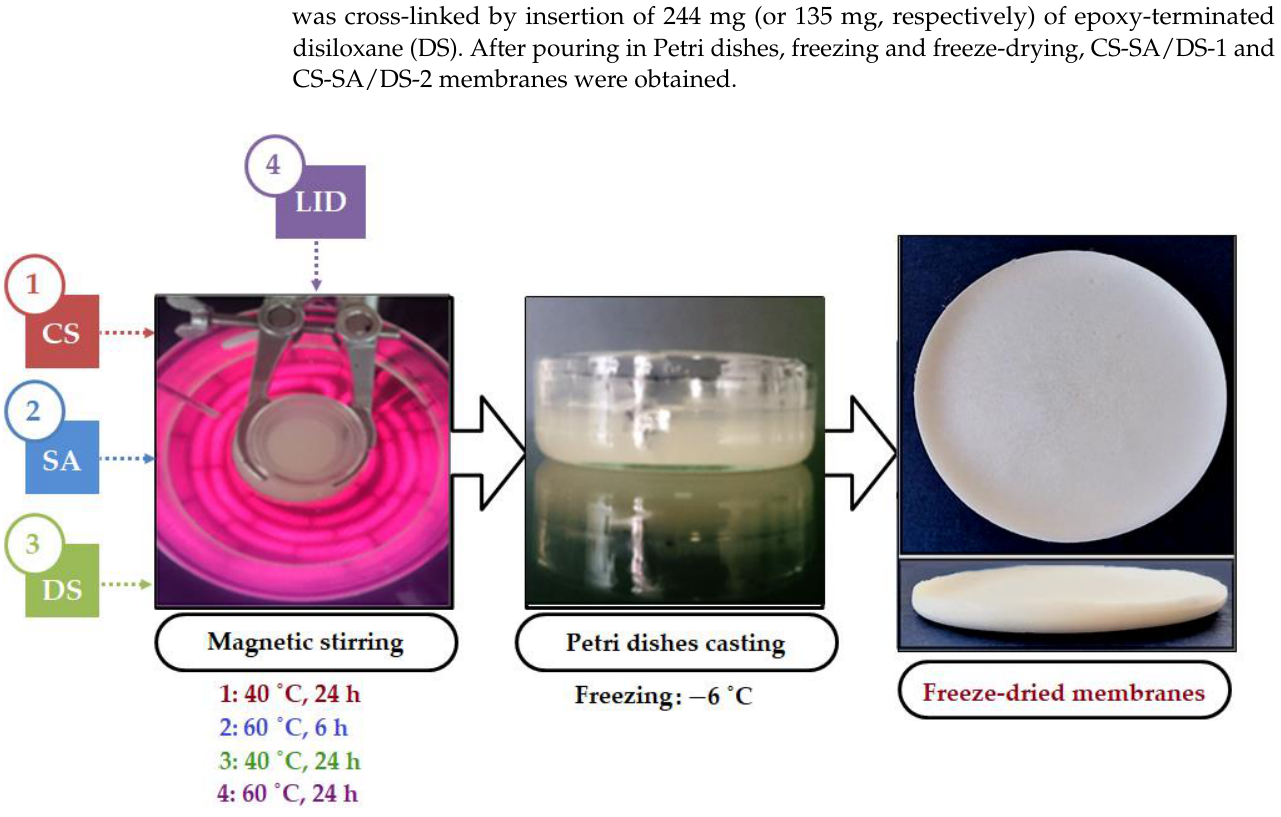
Figure 1. Schematic representation of the preparation process of lidocaine-loaded chitosan membranes.